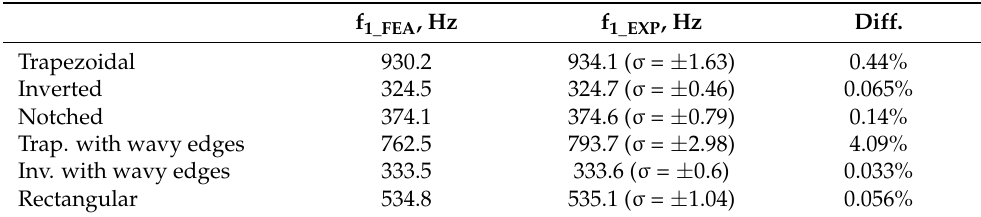
Table 6. Experimentally assessed mechanical eigenfrequency values compared with the modal FEA results.